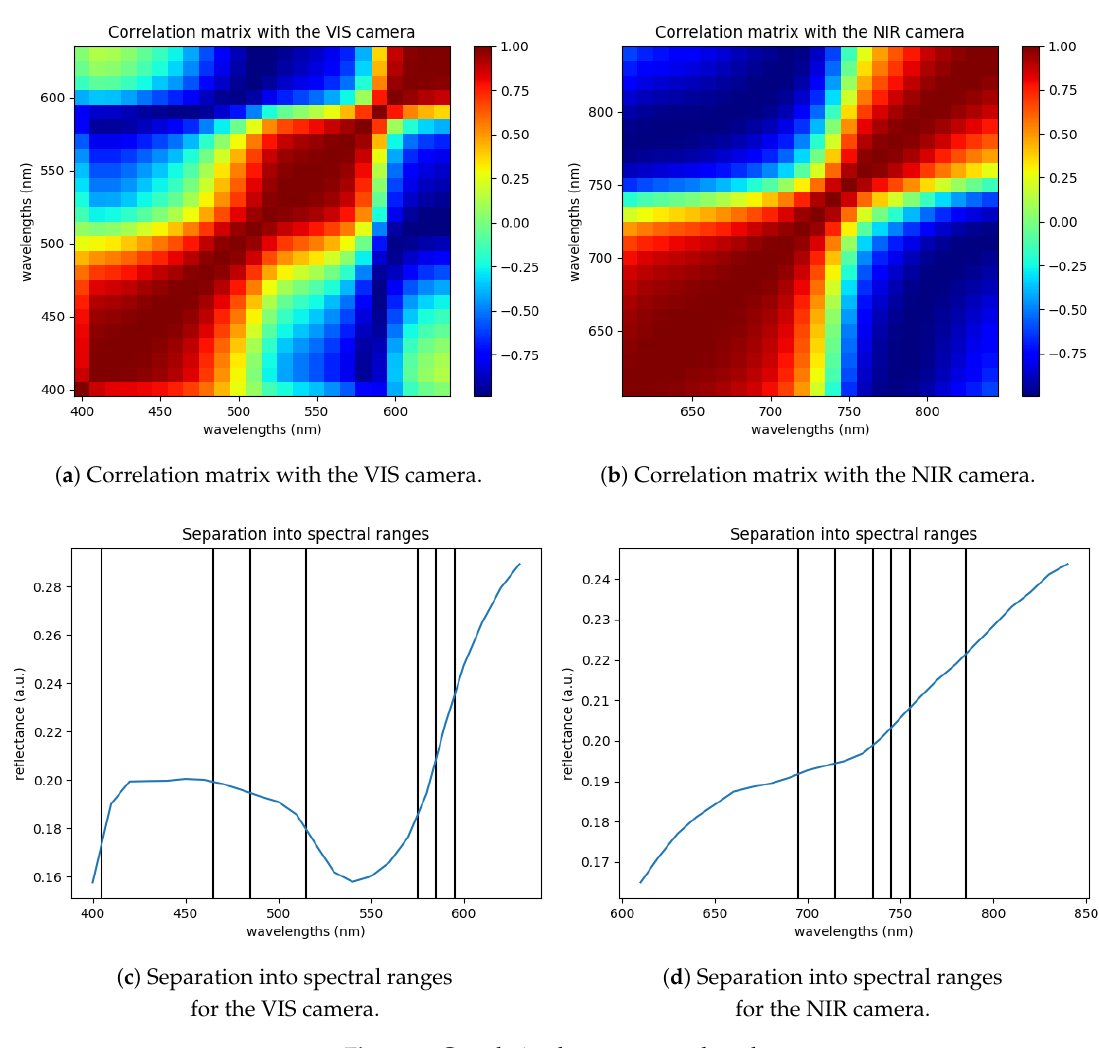
Figure 1. Correlation between